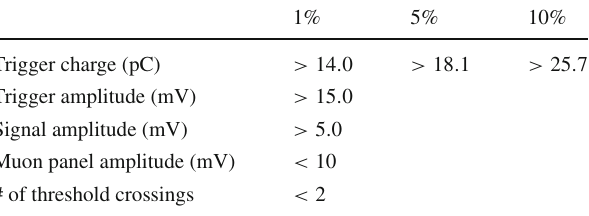
Table 2 Summary of selection cuts used to select SPE pulses in the LAPPDandtimingPMT,andtoensurethetriggerPMToperateswithan approximately Gaussian profile. Only the trigger charge cut is sample-